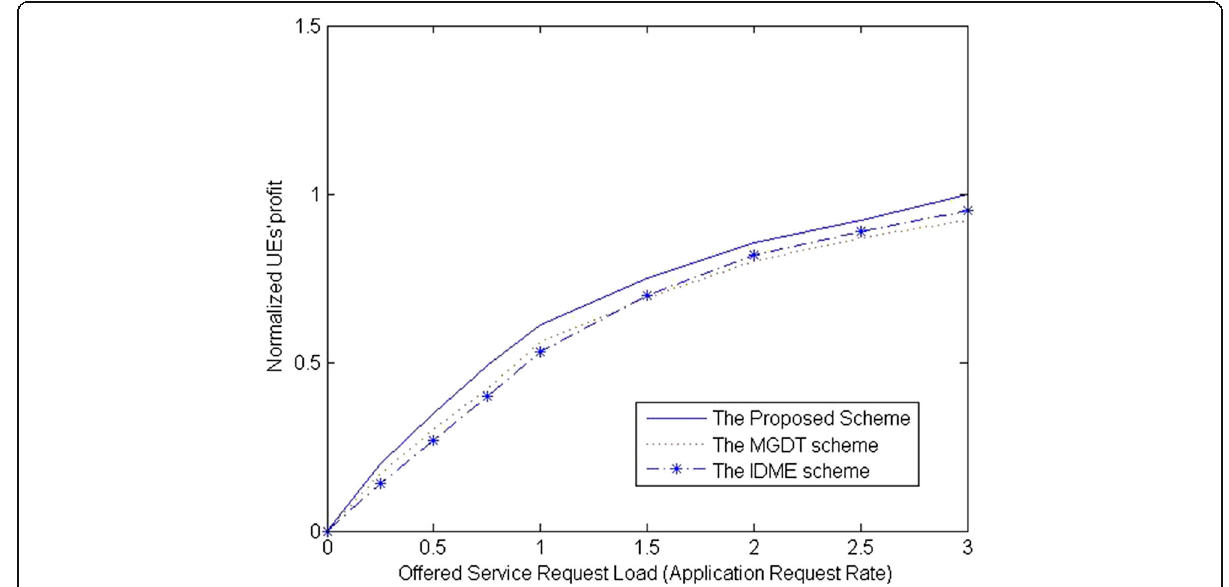
Fig. 4 Normalized UEs ’ profit in the UPN